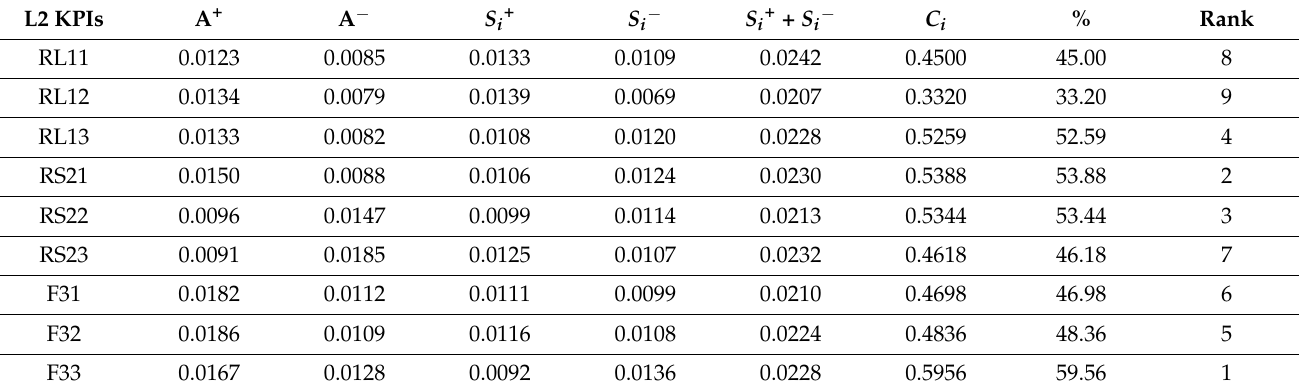
Table 6. Final results of TOPSIS for scenario 1